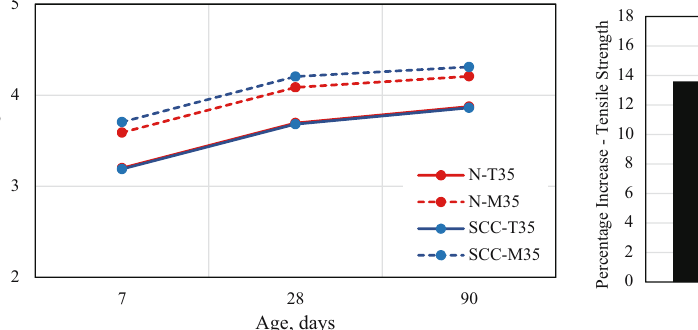
Figure 11: Tensile strength improvement using magnetized water instead of tap water for all